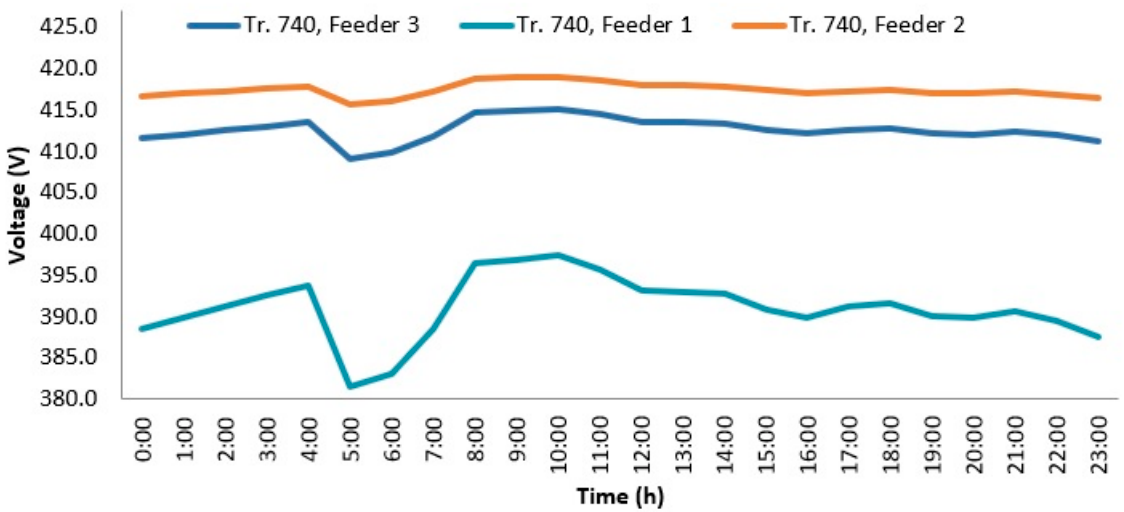
Figure 18. Voltage profiles at the end of Transformer 740 in summer with 60% EVC & off-peak charging.